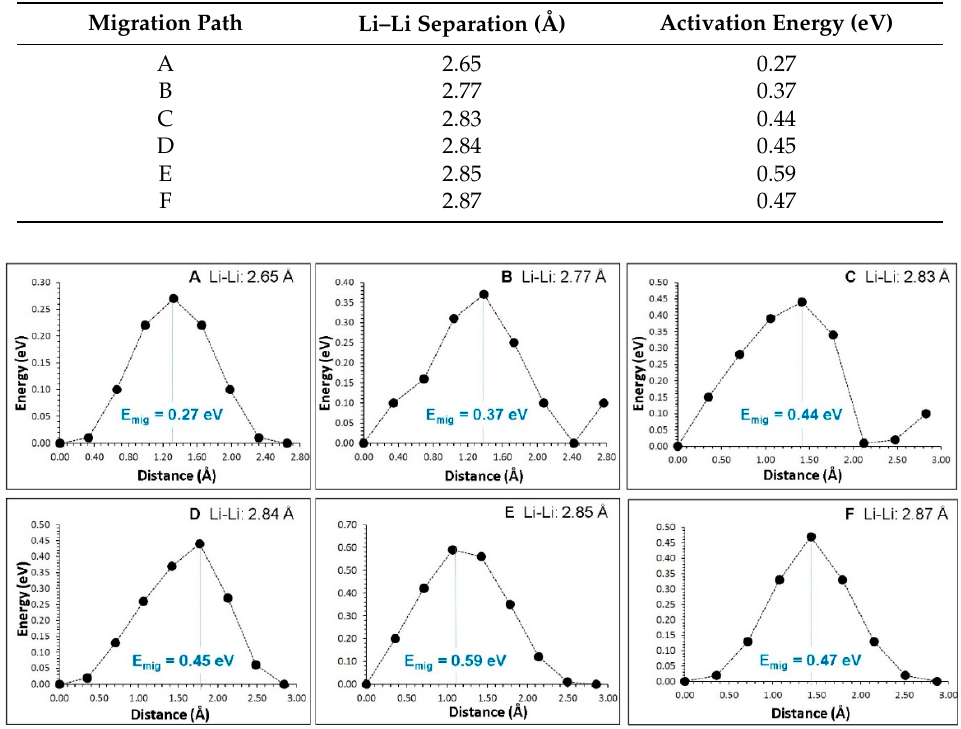
Figure 3. Different Li trajectory views ( a ) and ( b ) possible long-range lithium vacancy migration paths considered. Yellow, light blue, purple, green, grey and light brown color atoms correspond to different Li hopping trajectories. Table 2. Calculated Li–Li separations and activation energies using classical pair-potential method for the lithium ion migration between two adjacent Li sites (as shown in Figure 3). Table 3. Possible long-range Li ion diffusion paths and their corresponding overall activation energies.